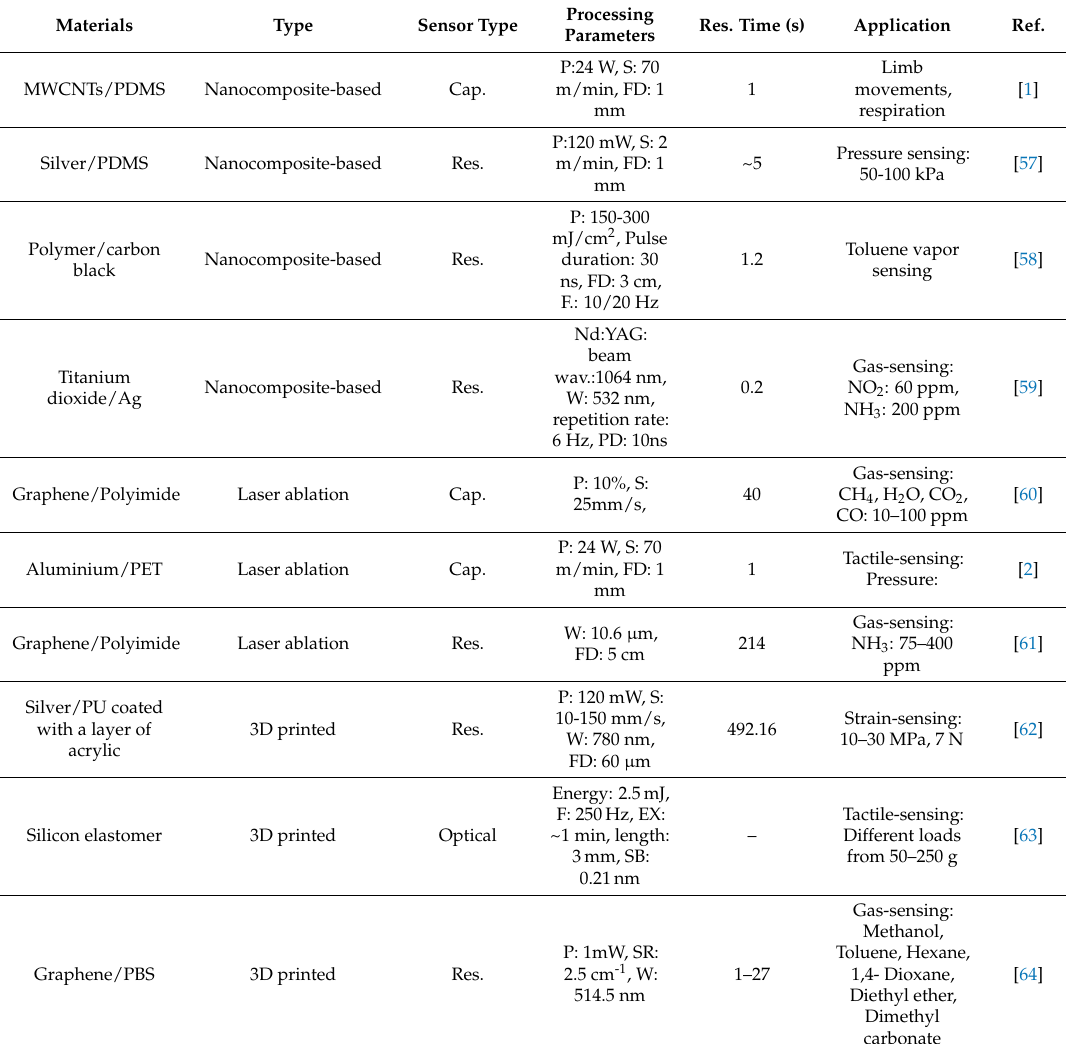
Table 1. Comparison of the performance of the sensors developed from the three types of laser-assisted printing